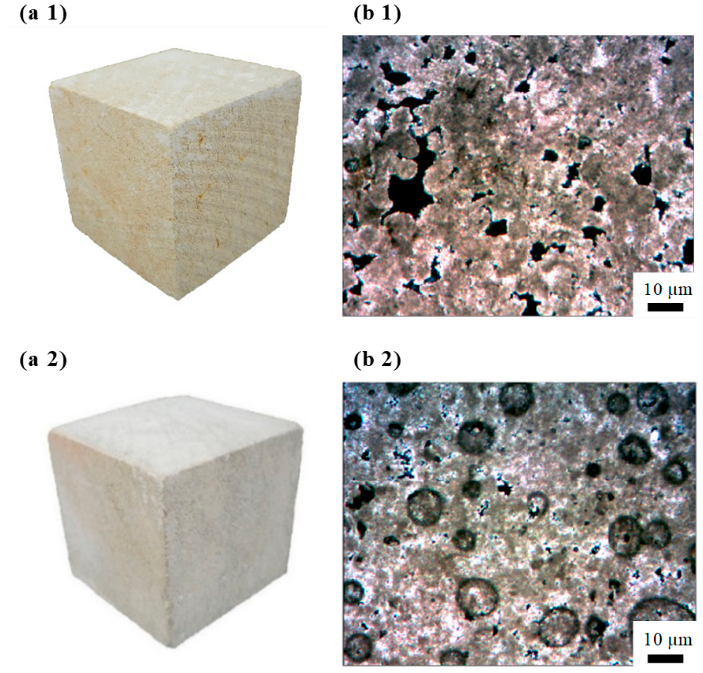
Table 2. Water absorption by capillarity (WAC) coefficients for samples.